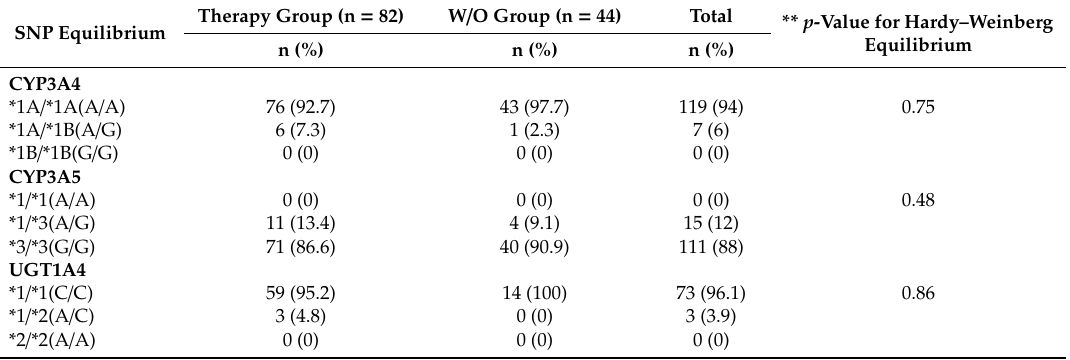
Table 3. Allele and genotype frequencies of CYP3A4, CYP3A5 and UGT1A4 genes in BC